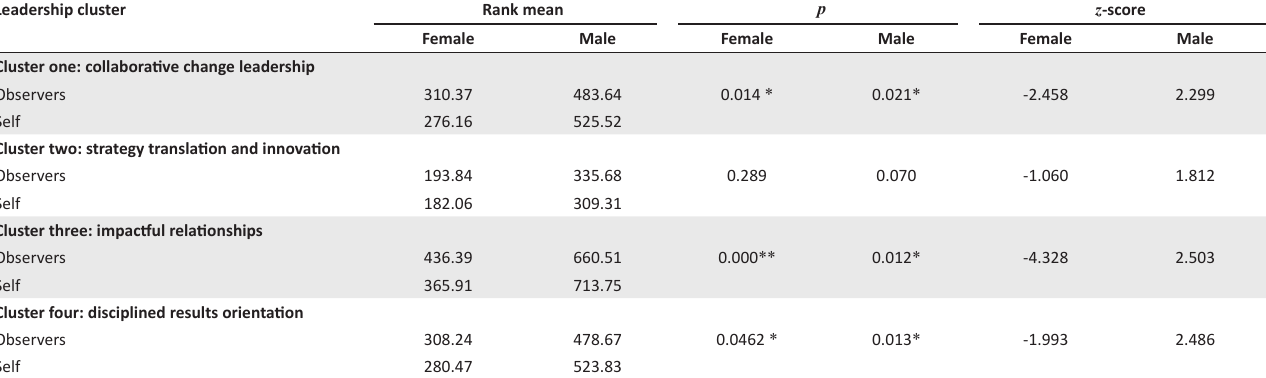
TABLE 1: Wilcoxon–Mann–Whitney test – comparison of self-perception accuracy per gender for each of the four leadership clusters. Leadership